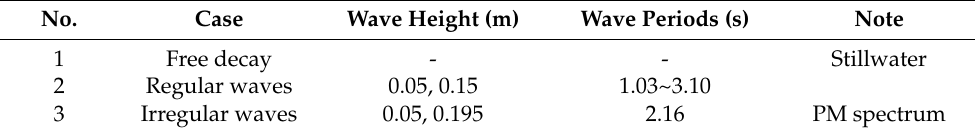
Figure 6. Configuration of the platform and mooring lines in the water tank test. Table 4. Environmental conditions of the tests. Table 4. Environmental conditions of the tests.